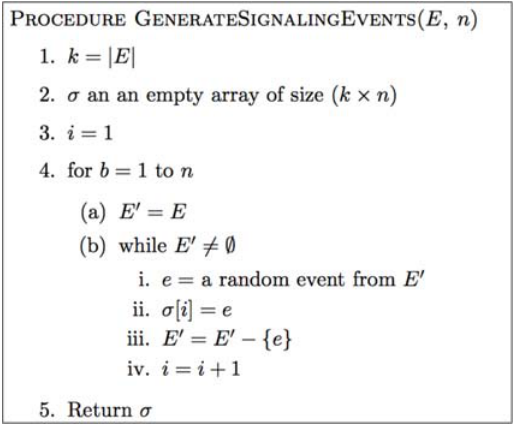
Figure 6. The Algorithm That Implements the Signaling Network Event Generator. This routine generates the time block/ firing structure. Given a set of events, E, and the number of blocks for which the SPN will be executed, n, G ENERATE S IGNALING E VENTS generates n blocks of events, each consisting of | E | events ordered randomly. In each block, every event in E occurs exactly once.